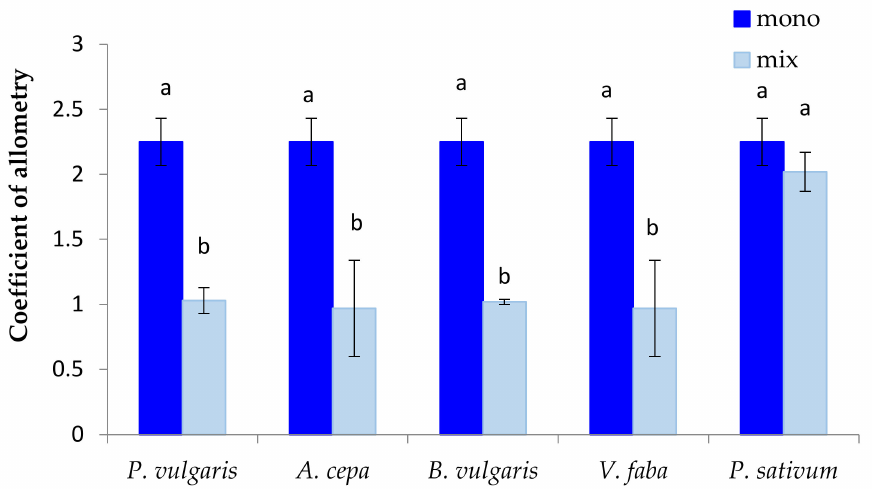
Figure 10. Coefficient of allelometry of P. oleracea grown with crop seeds (mono = weed alone; mix = weed grown toghether with crop). Bars represent the means of 4 replicates ± SE. Bars topped by the same letter indicate no significant difference between treatments at the 5% level using Duncan’s multiple-range